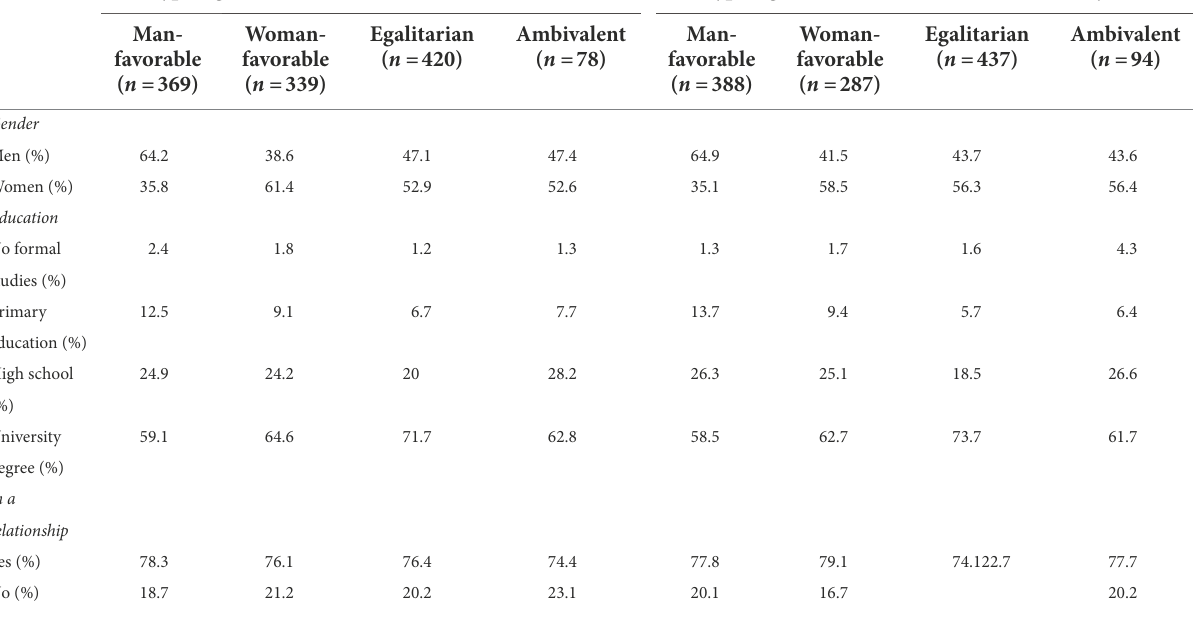
TABLE 1 Sociodemographic characteristics of the sample according to SDS adherence typologies for sexual freedom and sexual shyness. Typologies of SDS adherence for sexual